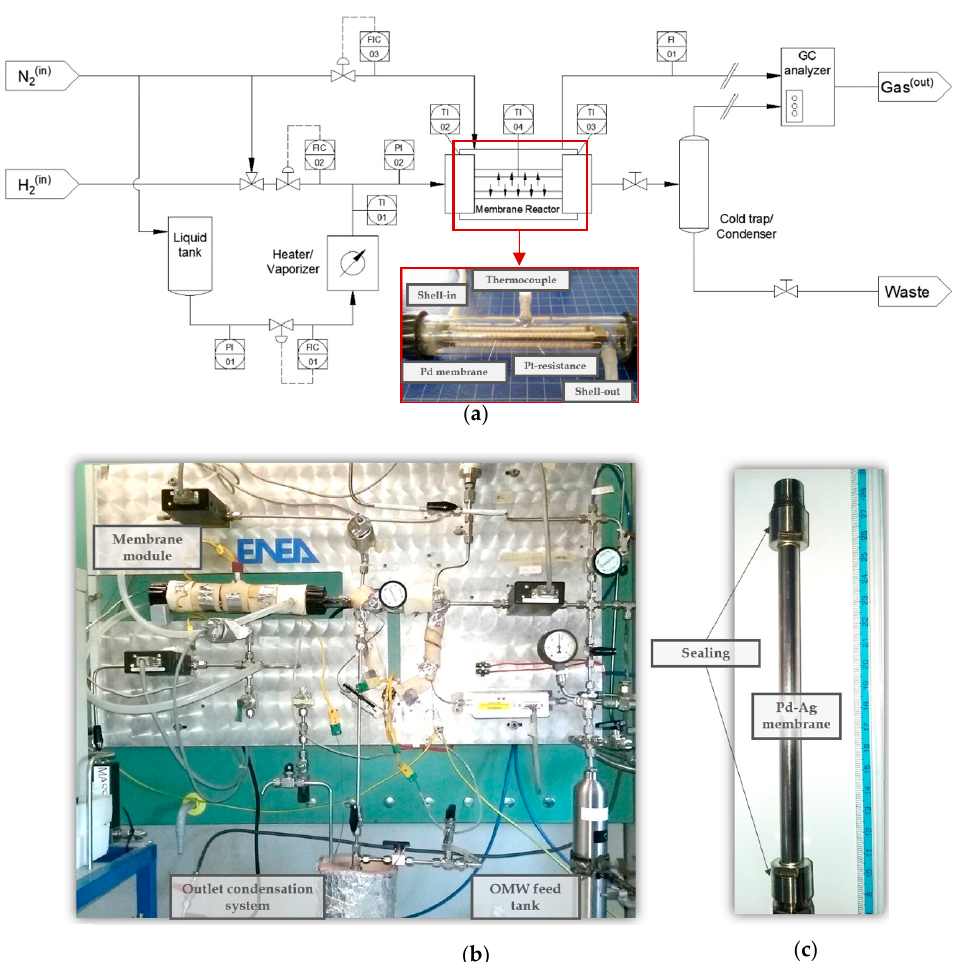
Figure 1. Experimental device for permeation/reaction tests: ( a ) general scheme and membrane cell details; ( b ) real assembly photography; and ( c ) finger-type Pd membrane.